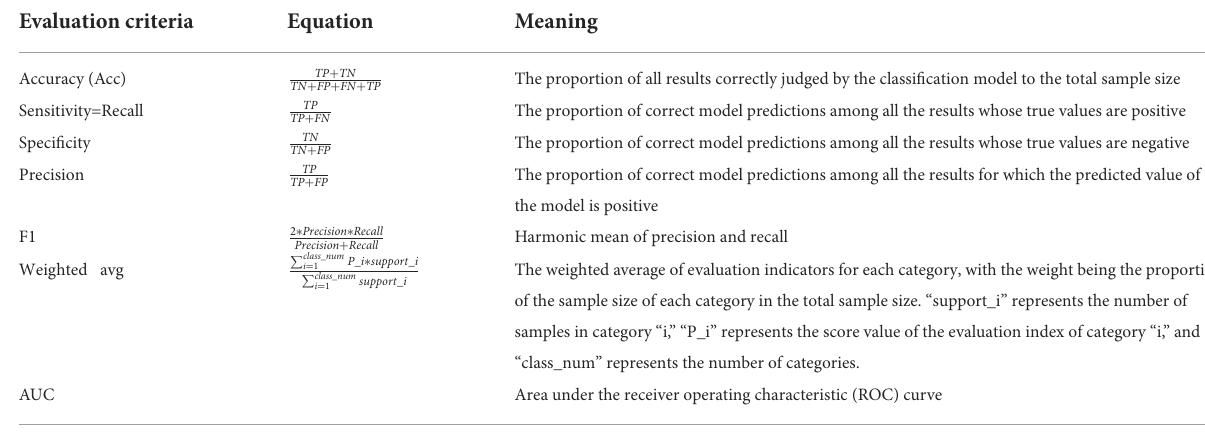
TABLE 2 Evaluation criteria.